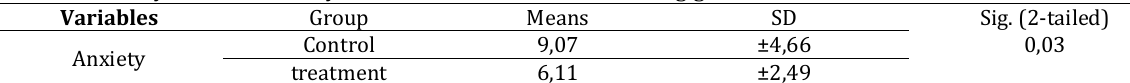
Table 2. Anxiety in the Coronary Heart Disease clients after being given self affirmation Variables